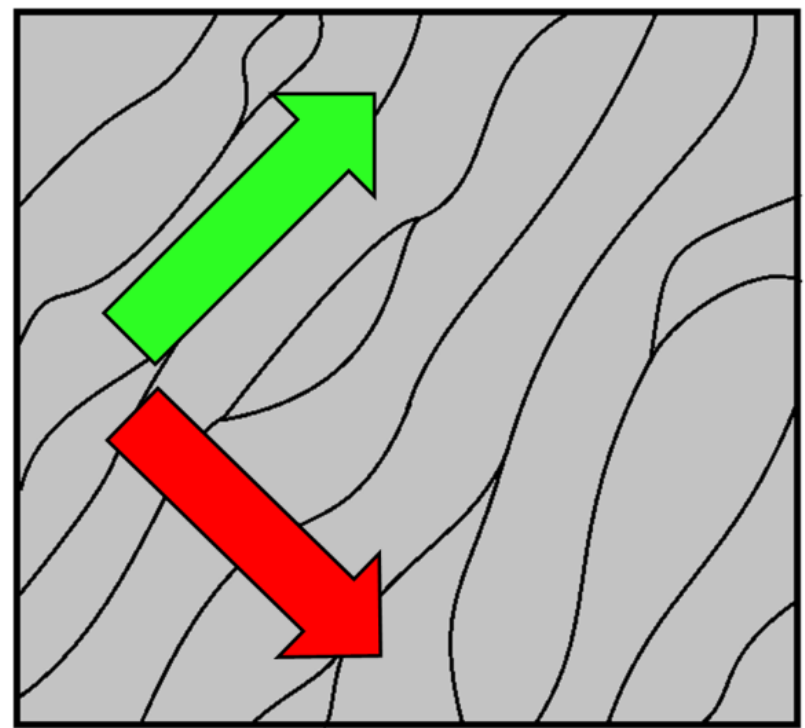
Figure 7. Schematic illustration of the directional dependence of the electrical resistivity on the structure of the layer. The box indicates a sample with steps and bunched steps that are indicated by the black lines. The green arrow indicates the direction that was found to yield lowest electrical resistivity (i.e., higher conductivity) values for thin graphene films. The red arrow indicates the direction of the highest resistivity values found on those samples. For thick graphene and graphite films, the directions are completely opposite.